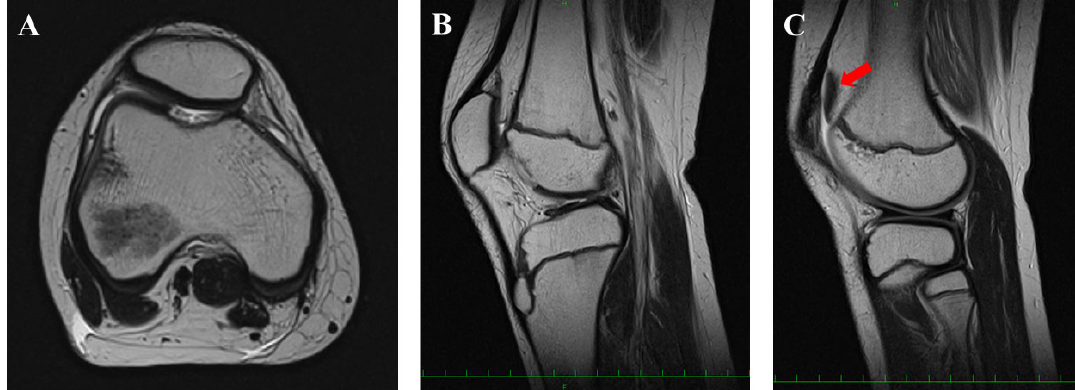
Figure 2. Preoperative magnetic resonance imaging findings (T2 ‐ weighted images). Axial view ( A ). Sagittal views ( B , C ). The osteochondral lesion was completely detached from the intercondylar groove ( red arrow ).